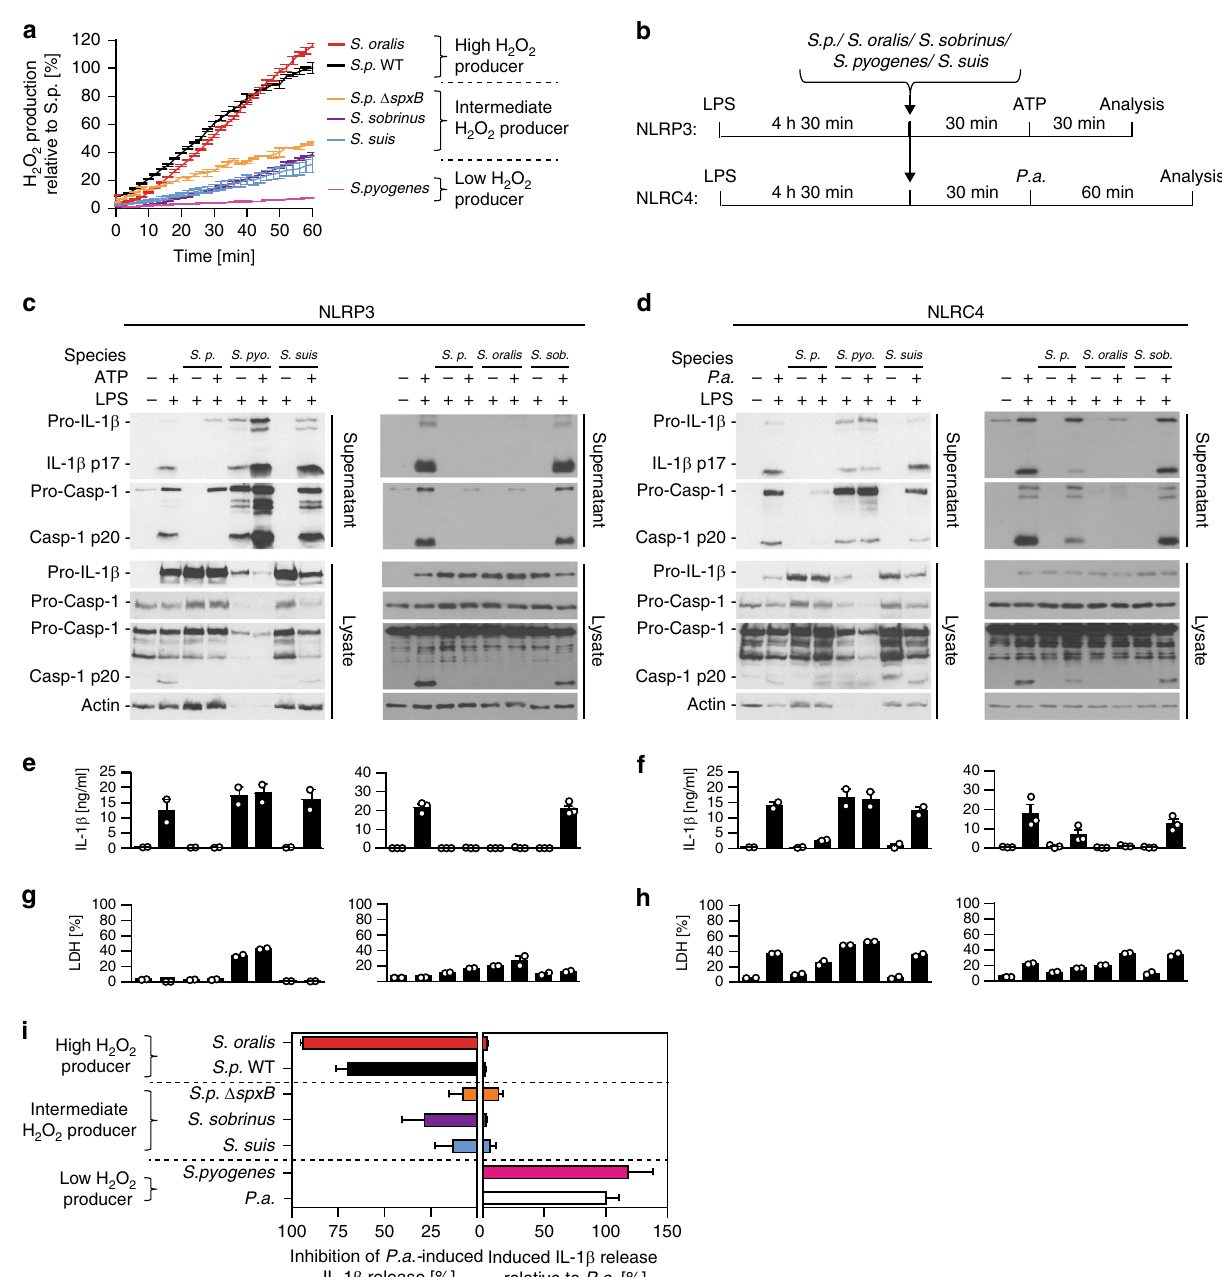
Fig. 5 High H 2 O 2 -producing bacteria block in fl ammasome activation whereas low producers do not. a H 2 O 2 production by S. oralis , S. pneumoniae Δ spxB (D39), S. sorbnius , S. suis , S. pyogenes relative to that by S. pneumoniae WT (D39) (100%). Data are representative of two independent experiments performed in duplicates or triplicates presented as the mean ± s.d. b Schematic diagrams of experimental setups used in ( c – h ). c , d Immunoblot analysis of Caspase-1 and IL-1 β processing, e , f ELISA analysis of corresponding supernatants for IL-1 β secretion and g , h LDH release of LPS-primed BMDMs pre- treated with S. pneumoniae D39 WT ( S. p .), S. pyogenes ( S. pyo .), S. suis , S. oralis or S. sobrinus ( S. sob .) (MOI 40) for 30 min before c , e , g stimulation with ATP (5 mM) for 30 min or d , f , h infection with P. aeruginosa (MOI 20) for 60 min. Data in c and d are representative of two or three independent experiments, respectively. ELISA and LDH release data are from two or three independent experiments and are depicted as the mean ± s.e.m. i Relative in fl ammasome inhibition or activation by Streptococcus species presented as the mean ± s.e.m. Inhibition depicts decrease in P.a .-induced IL-1 β release during co-infection with indicated bacteria. Activation depicts IL-1 β release by indicated bacteria relative to that by P.a .. Data are presented as the mean ± s. e.m. of 2 – 9 experiments. Source data are provided as a Source Data fi